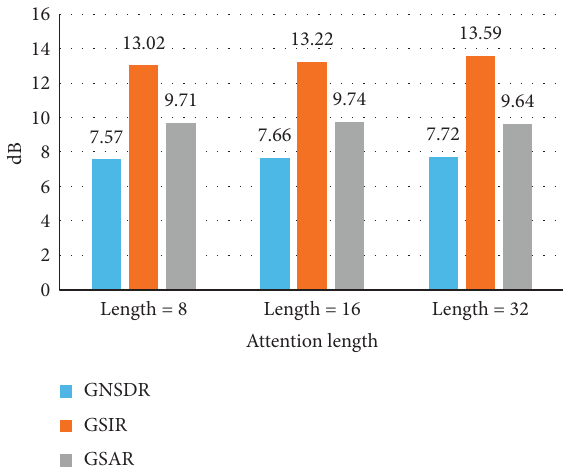
Figure 7: The comparison for the effect of different attention lengths. Figure 5: The comparison for the effect of MLRR, RNF, DRNN-